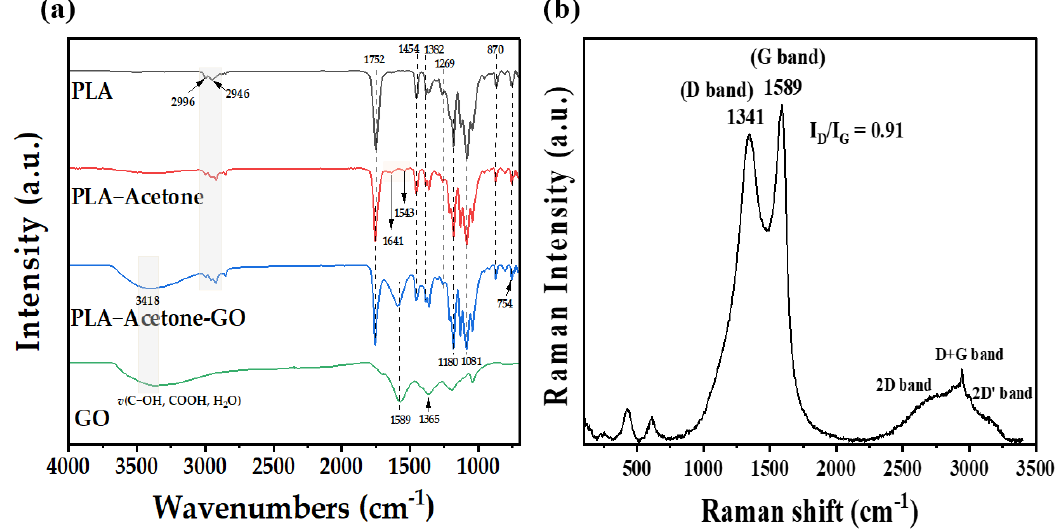
Figure 6. ( a ) FTIR spectra of PLA, PLA-acetone, PLA-acetone-GO (GO/PLA), GO, and ( b ) Raman spectrum of GO/PLA.